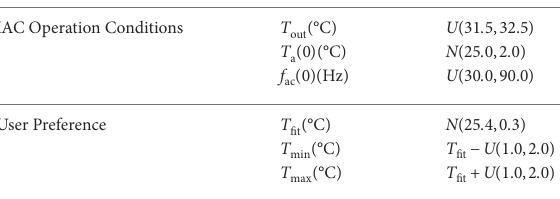
TABLE 2 Random initialization of iac operation condition and user preference